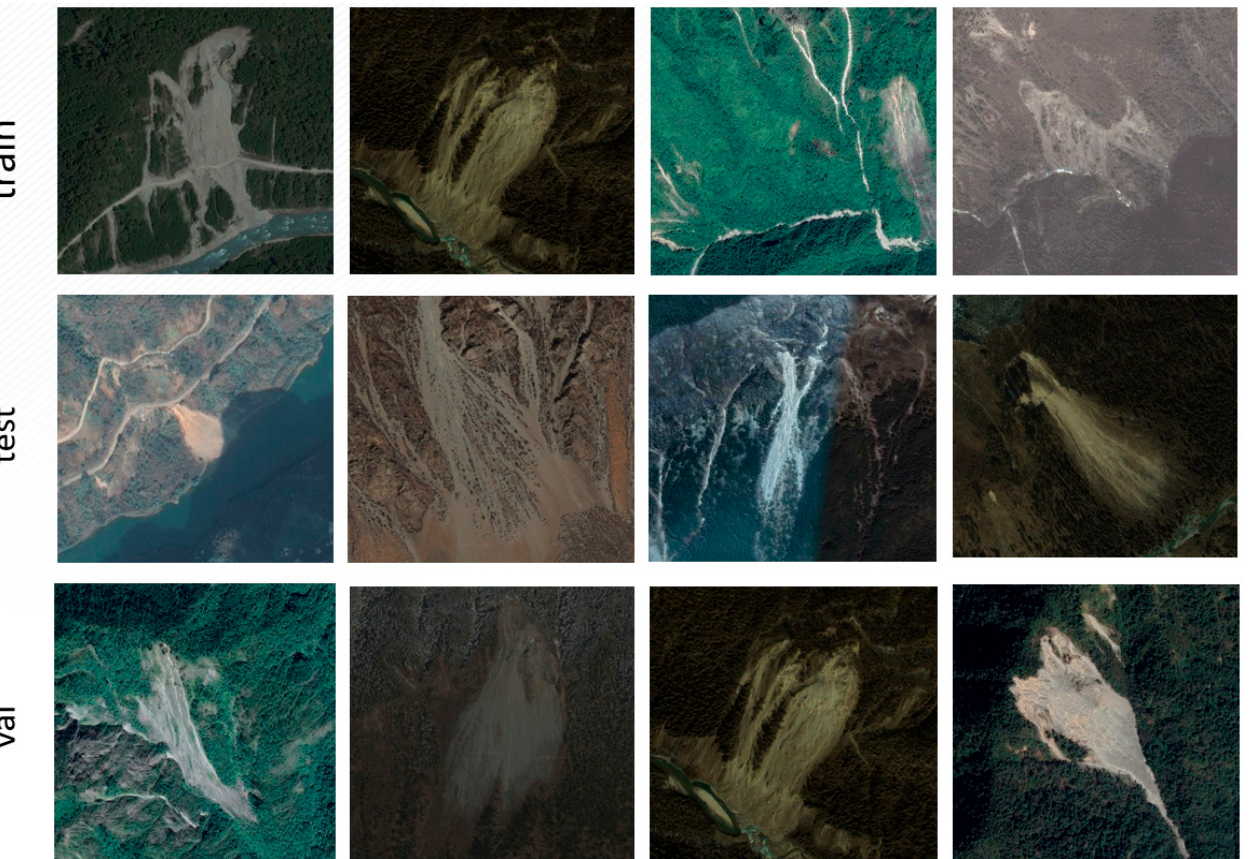
Figure 15. Partial dataset of landslides.